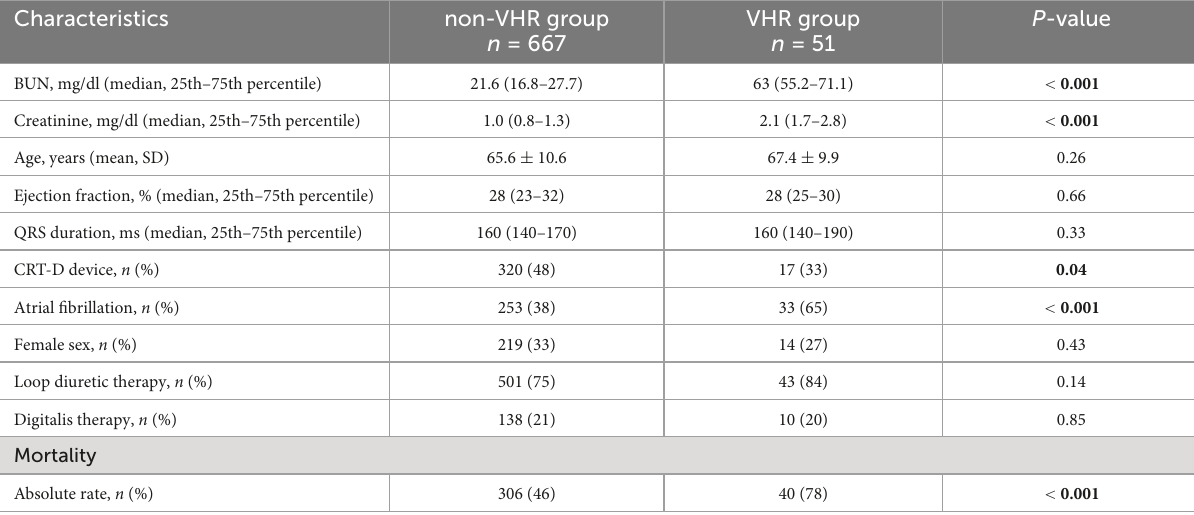
TABLE 4 Baseline characteristics comparing the non- and very-high-risk (VHR) patient groups.